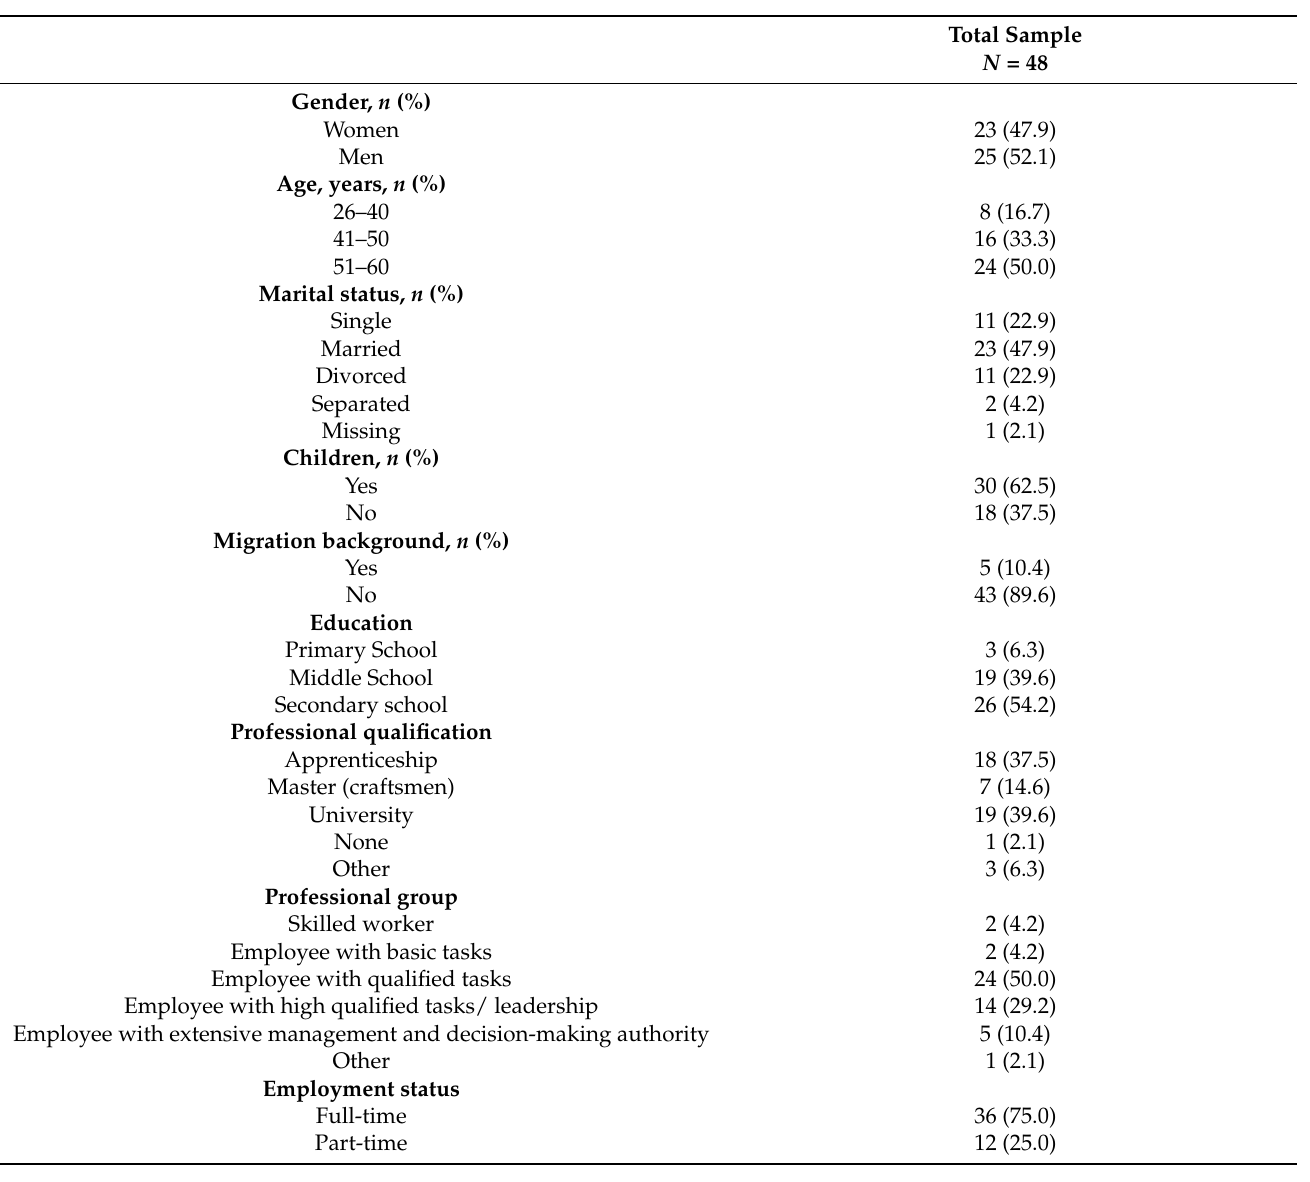
Table 1. Sociodemographic and occupational characteristics of the study